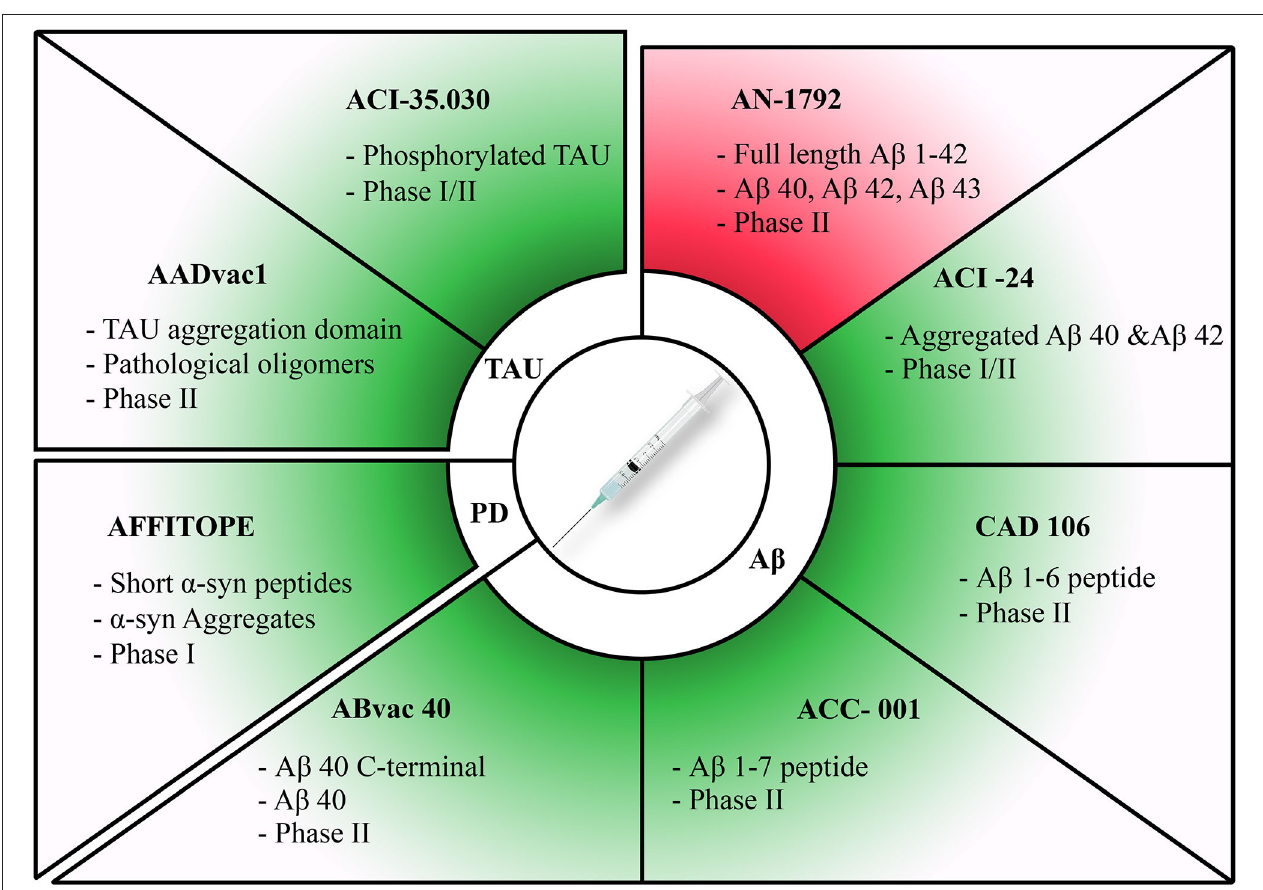
FIGURE 1 | Summary of active immunization therapies assessed in clinical trials for different diseases. Discontinued trials highlighted in red and ongoing trials highlighted in green. Therapies have been categorized according to each pathology they target. The target of each therapy along with its current clinical trial phase have been stated for each